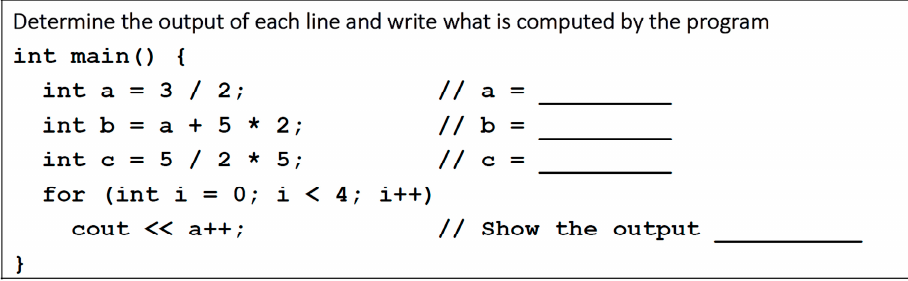
Figure 4. LiquiZ randomized code